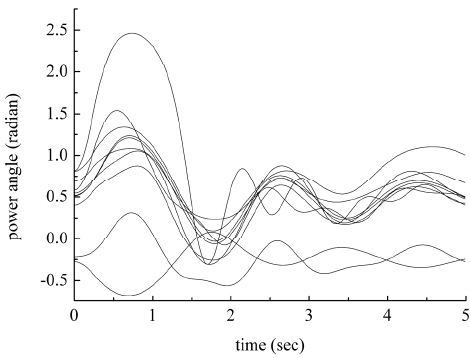
Figure 8. Power angle curves of scheme one.